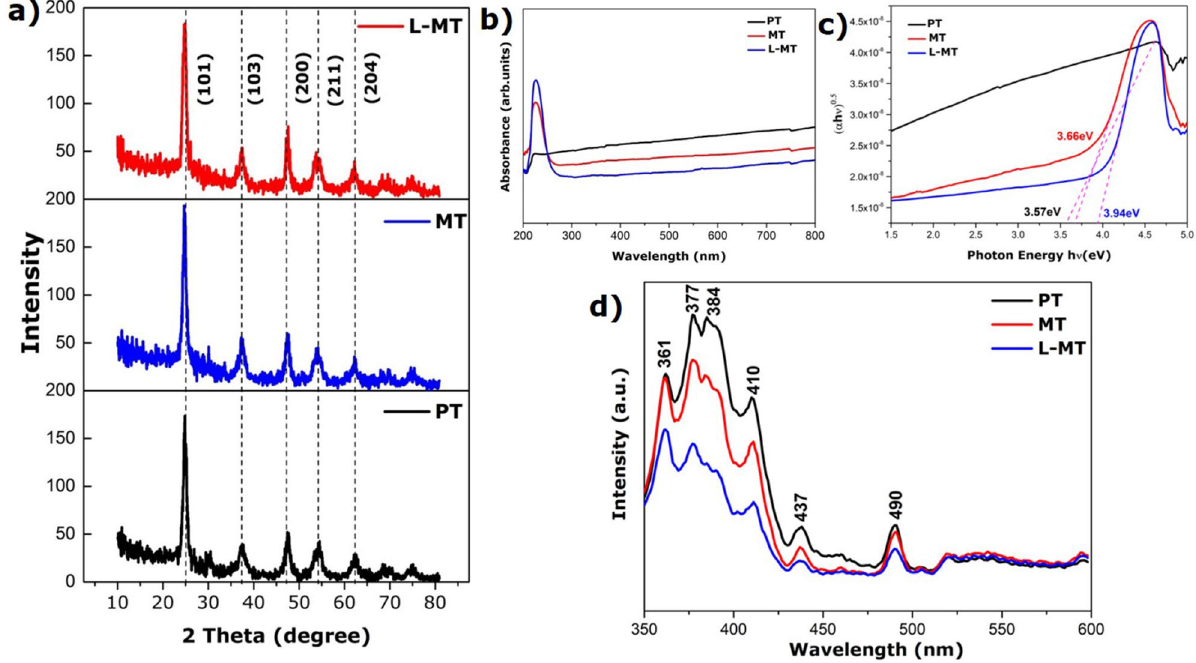
Figure 1. XRD patterns ( a ). UV–Vis Spectrum ( b ). Tauc plot ( c ). Photoluminescence spectrum of as-prepared PT, MT and L-MT samples ( d